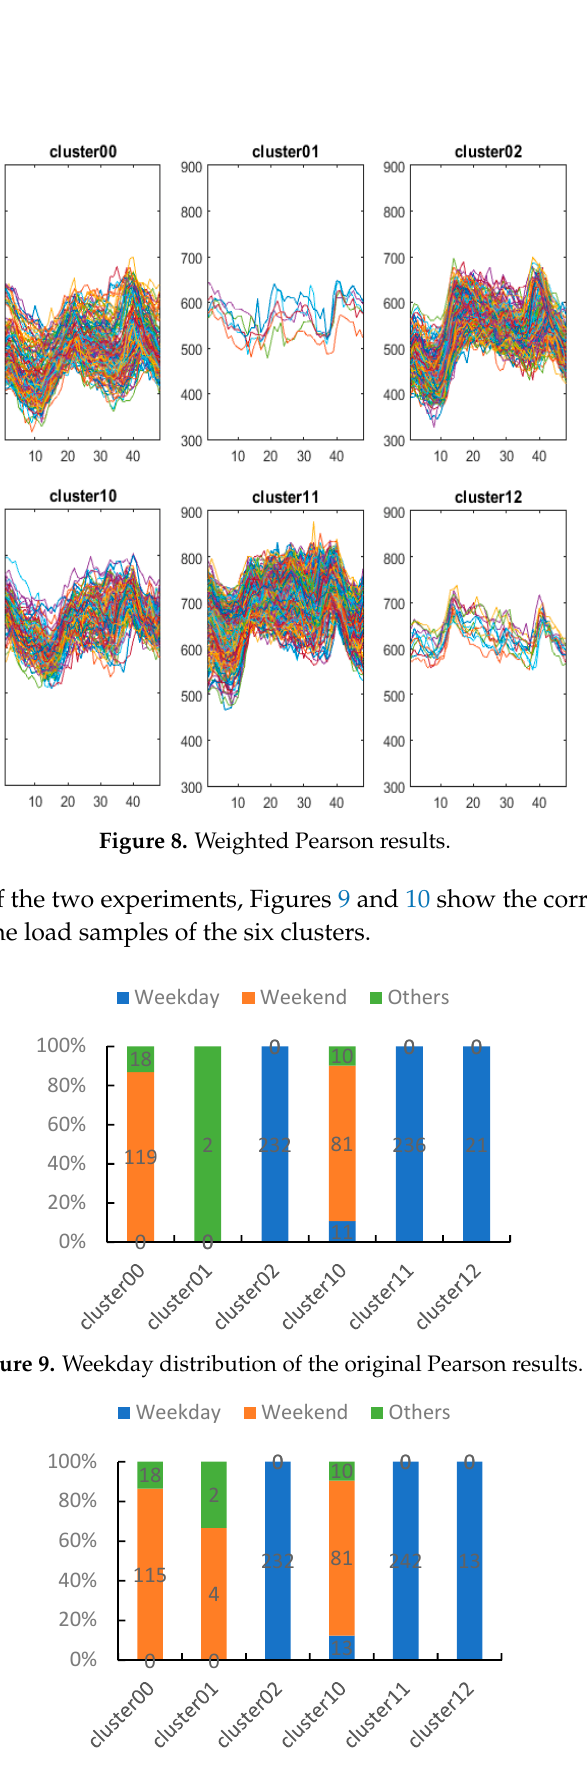
Figure 10. Weekdays distribution of Weighted Pearson Results.